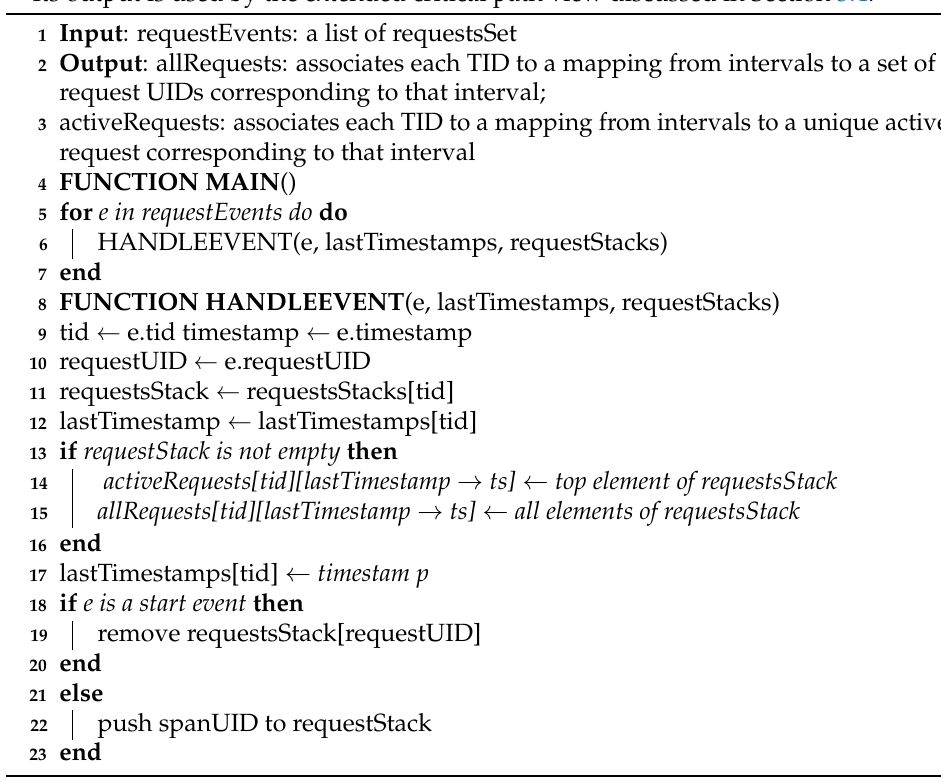
Figure 7. Simplified version of the Java data structure used for our critical path nodes. A node from the graph obtained by merging critical paths has all the information needed to traverse the graph for any thread of interest. Algorithm 1: Pseudo-code for the proposed synchronization algorithm. The al- gorithm associates each thread to the sequence of requests it is actively